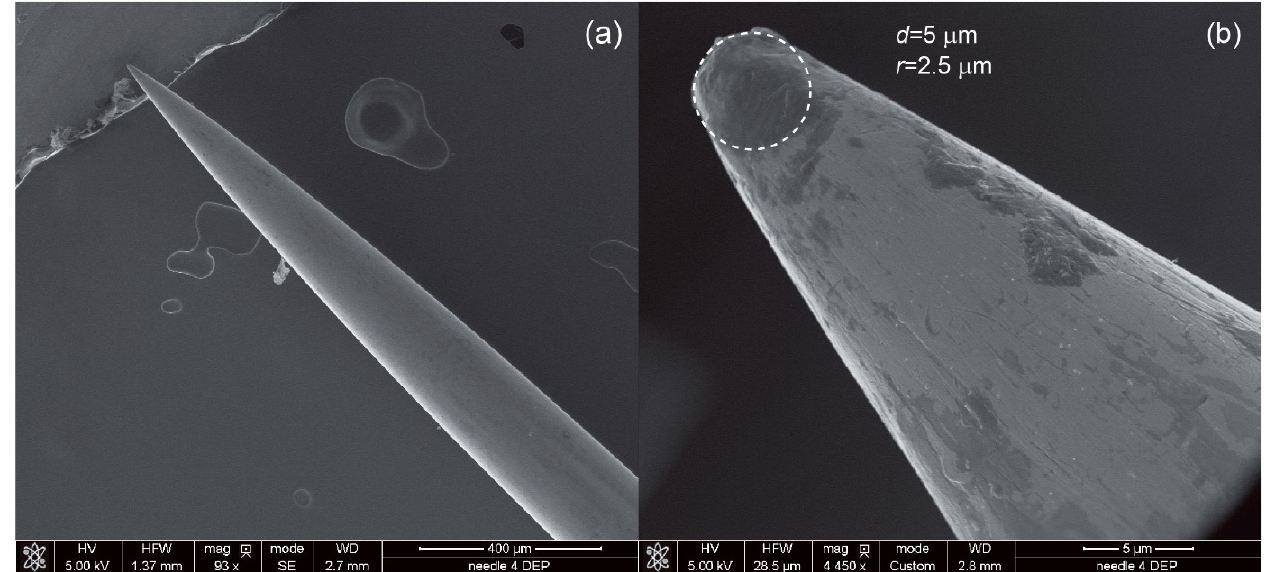
Figure 4. DEP electrode placed from the bottom of the SERS platform. The small diameter (5 μ m in comparison to the diameter of the needle at 260 μ m) results in a high electric-field gradient, which is required for effective dielectrophoretic deposition of the CTCs. ( a ) the general SEM view of the needle, ( b ) higher magnification with marked diameter of the end of the needle.